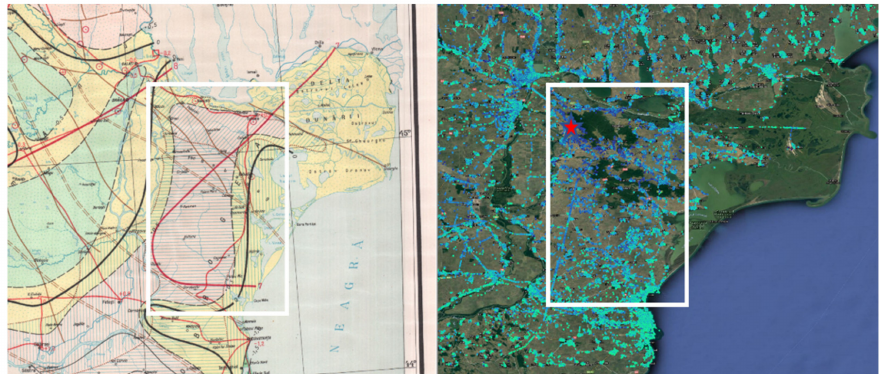
Figure 20. Qualitative correlation between a crustal motion map ( left , detail from [63]) and PSINSAR measurement ( right ).